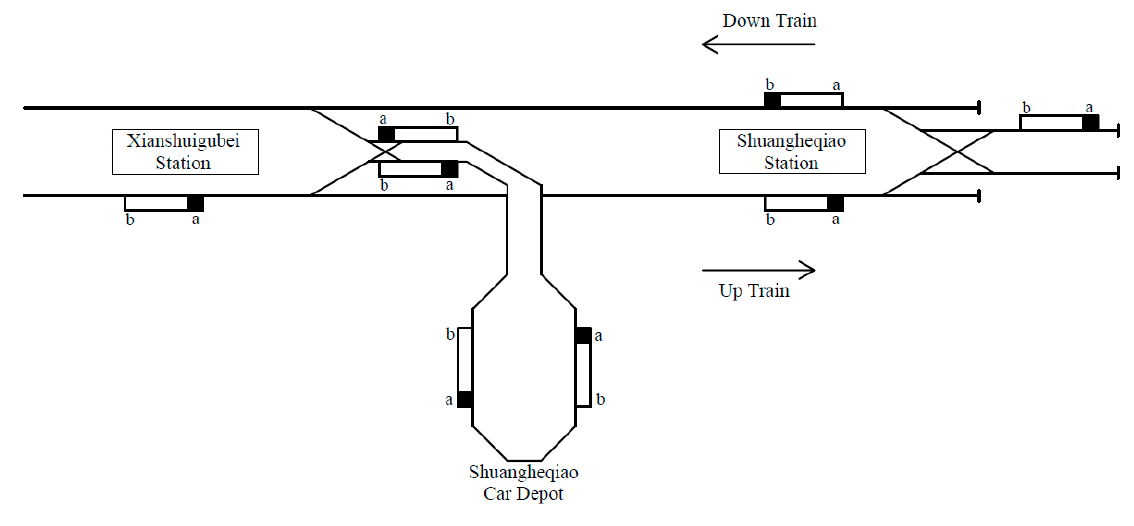
Figure 2. Train route.